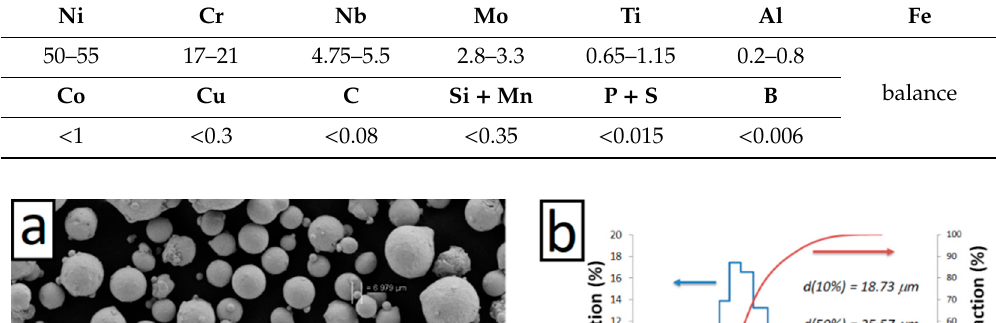
Table 1. Chemical composition in wt.% of the Inconel 718 EOS GmbH (Krailling, Germany) powders used in this work [44].